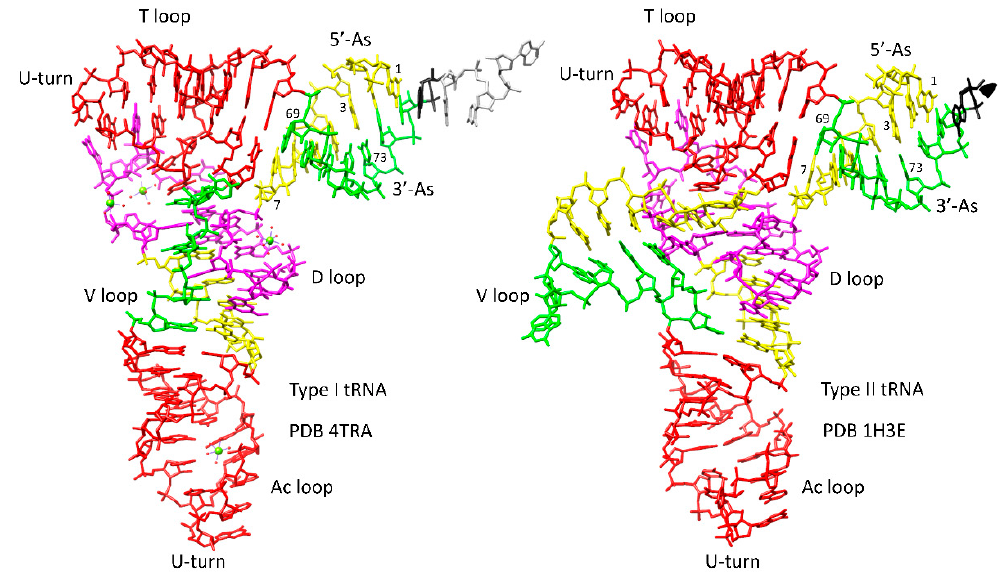
Figure 11. tRNA evolution. Homologous regions have the same color. Ac and T loop stem-loop-stems (17 nt) are red (initially ~CCGGGUUCAAAACCCGG). 5’-As (initially GCGGCGG) and homologous regions are yellow. 3’-As (initially CCGCCGC) and homologous regions are green. The D loop microhelix UAGCC repeat region (originally 17 nt) is magenta. Green spheres are Mg 2+ ions.